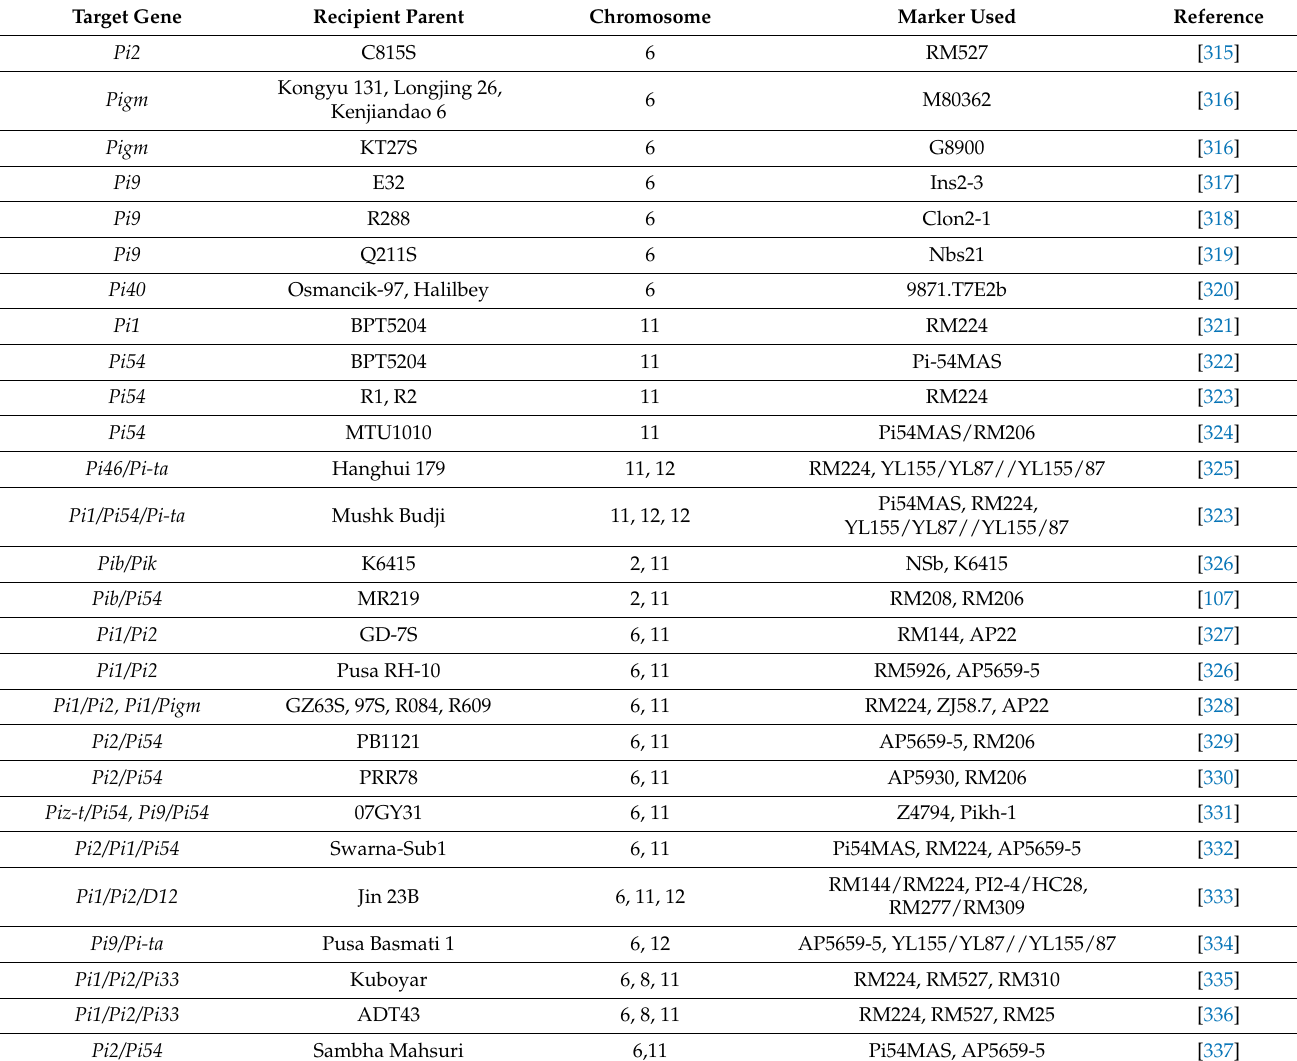
Table 5. Resistance genes introgressed in rice for blast improvement program.